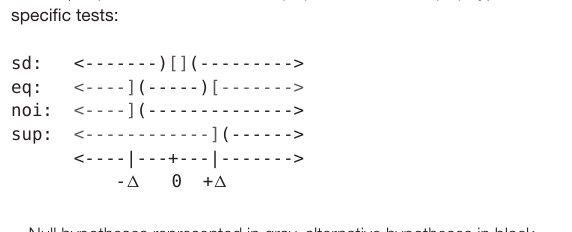
Frontiers in Plant Science |